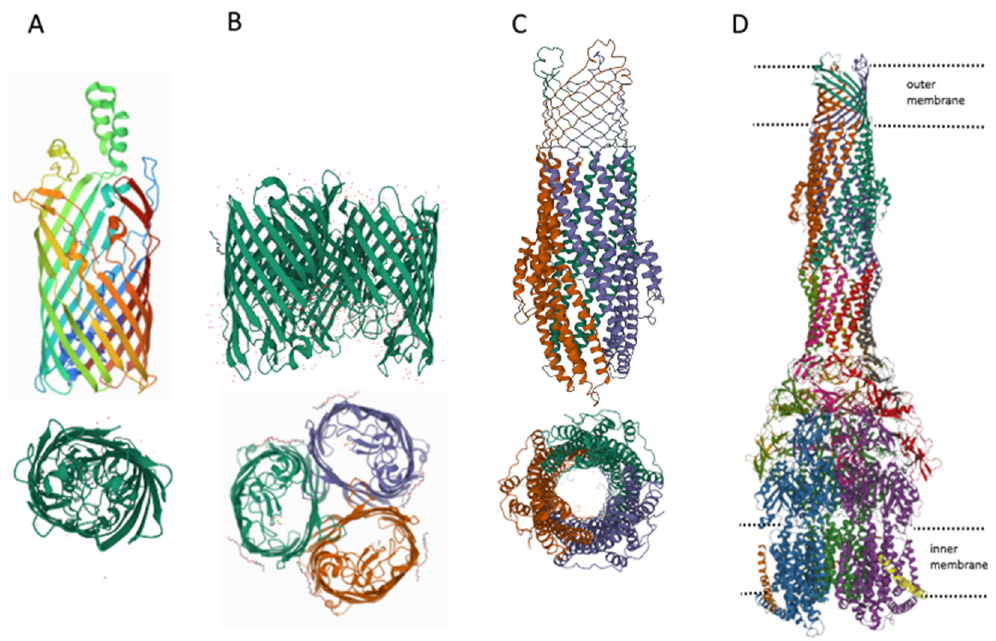
Figure 3. Structures of outer membrane proteins FadL ( A ), OmpF ( B ), TolC ( C ), and transporter AcrABZ ‐ TolC ( D ). PDB identifiers for FadL (2R88), and OmpF (6ZHP). AcrABZ-TolC ( D ). PDB identifiers for FadL (2R88), and OmpF